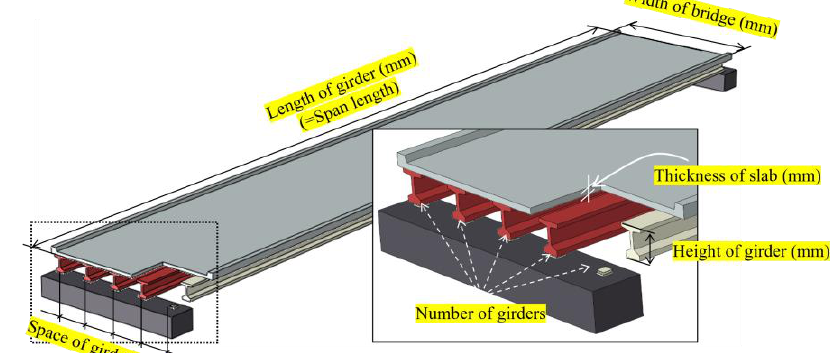
Figure 2. Input parameters.